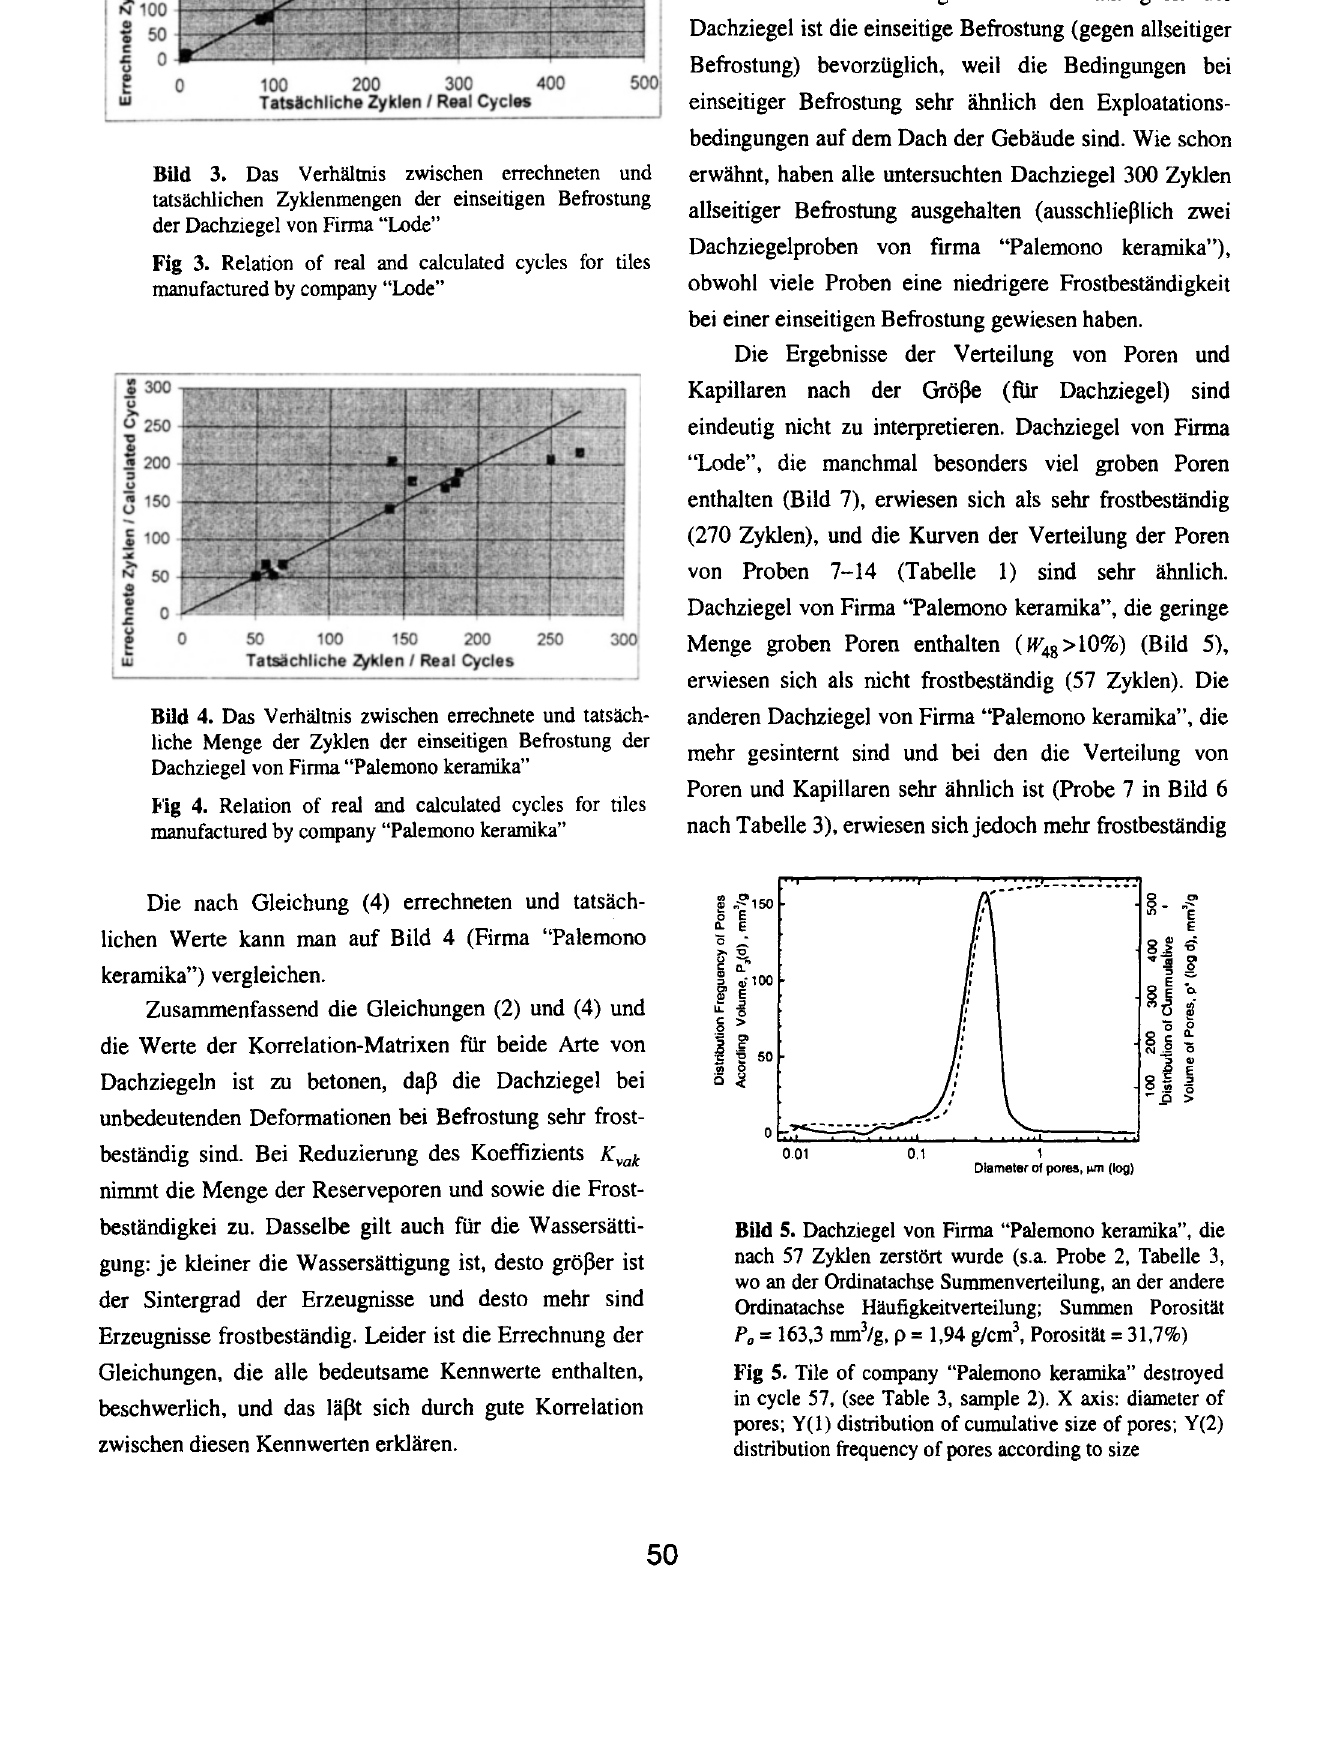
Fig 3. Relation of real and calculated cydes for tiles manufactured by company "Lode"